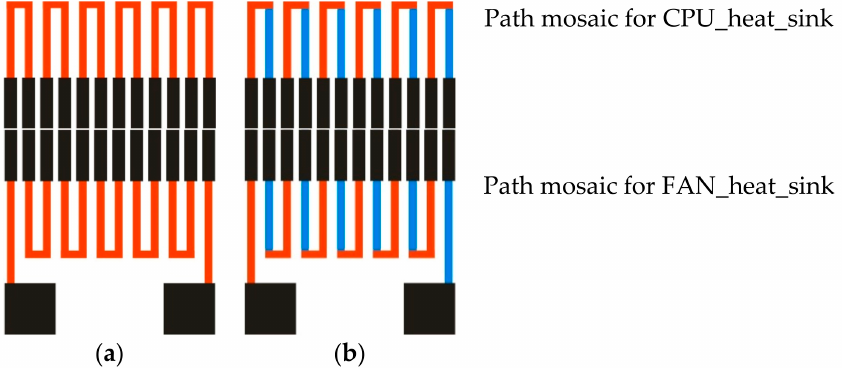
Figure 10. Thermopiles path mosaics: ( a ) for version A and E; ( b ) for version